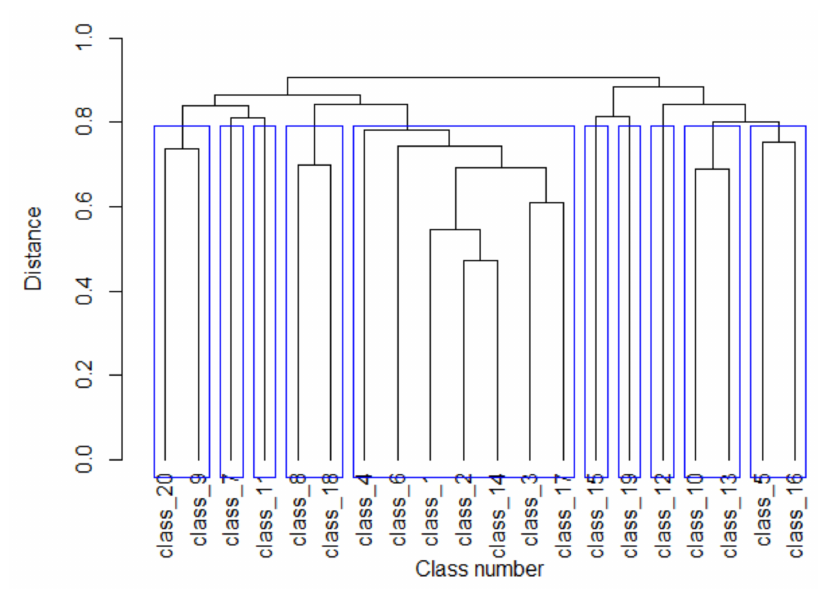
Figure 3. Cluster dendrogram of C. annuum promoter classes. Blue rectangles indicate clusters of promoter classes obtained at the association level of